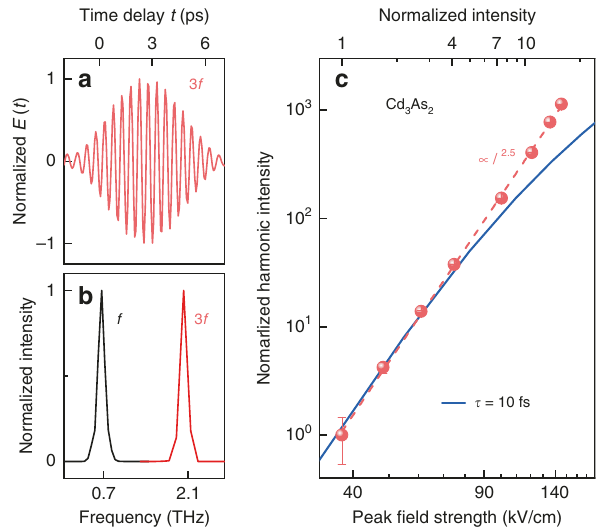
Fig. 1 Third harmonic generation in Cd 3 As 2 . a Time-resolved third- harmonic radiation characterized by its time-dependent electric fi eld E ( t ) recorded at room temperature. b Normalized power spectra of the harmonic radiation 3 f = 2.01 THz, and the excitation pulse f = 0.67 THz. c Dependence of the third-harmonic radiation intensity on the pump intensity (symbols) follows I 3f ∝ I f 2.5 (dashed line). Fit of the theoretical results is shown for the relaxation time τ = 10 fs (solid line). The error bars indicate the noise level at the corresponding data